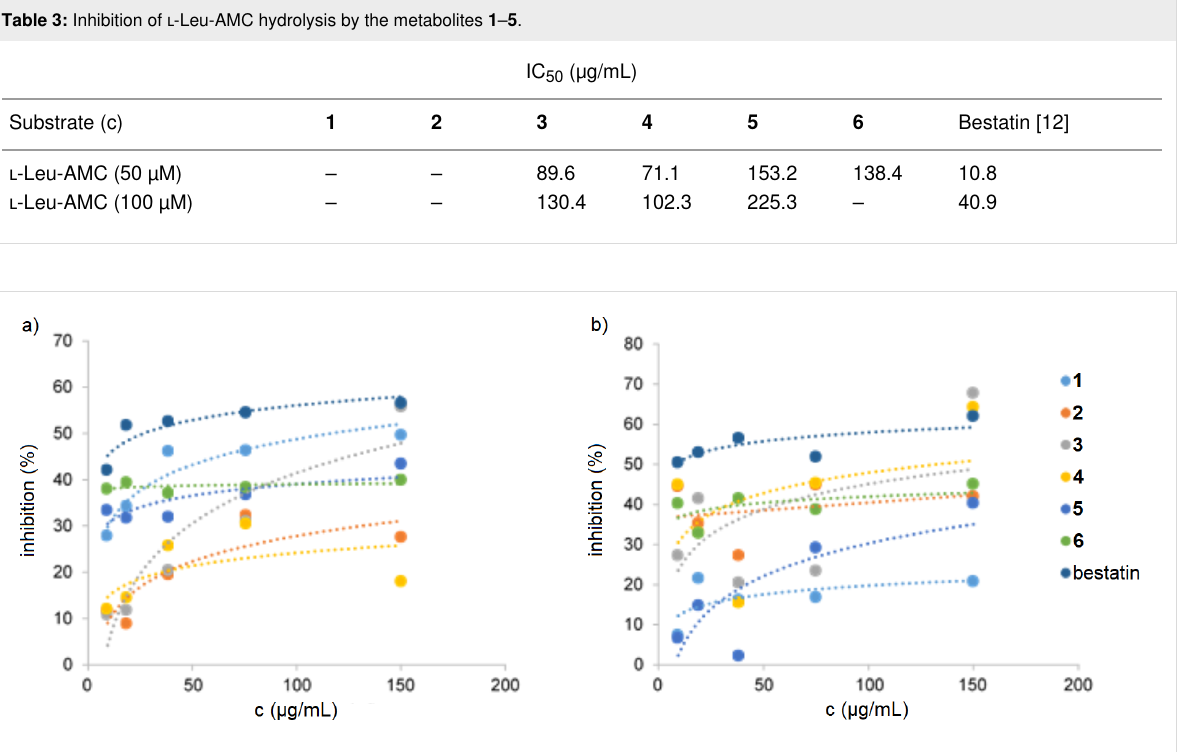
Figure 3: Inhibition Leu-AMC hydrolysis. a) c ( ʟ -Leu-AMC) = 100 µM. b) c ( ʟ -Leu-AMC) = 50